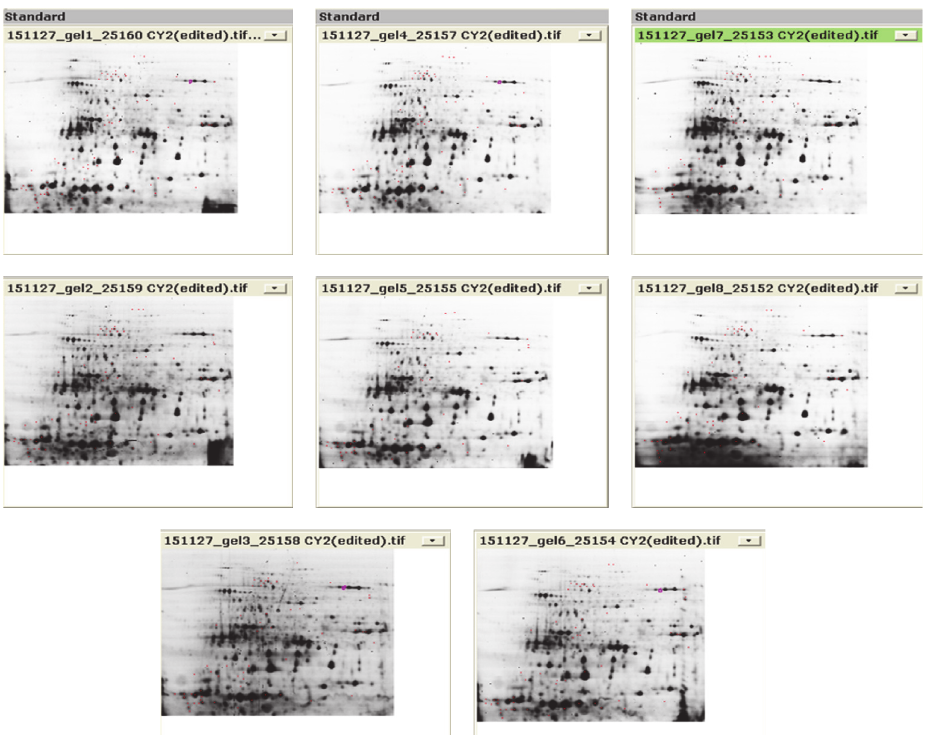
Figure 2: Overview of the fluorescence scans, internal